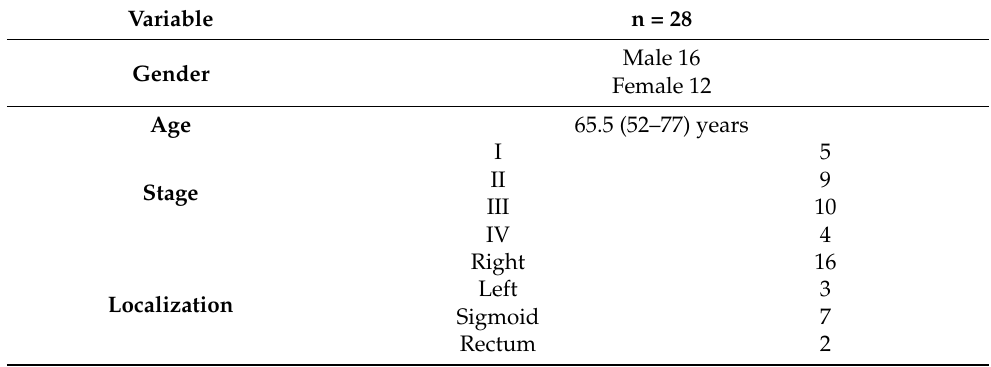
Table 1. Demographics and tumor